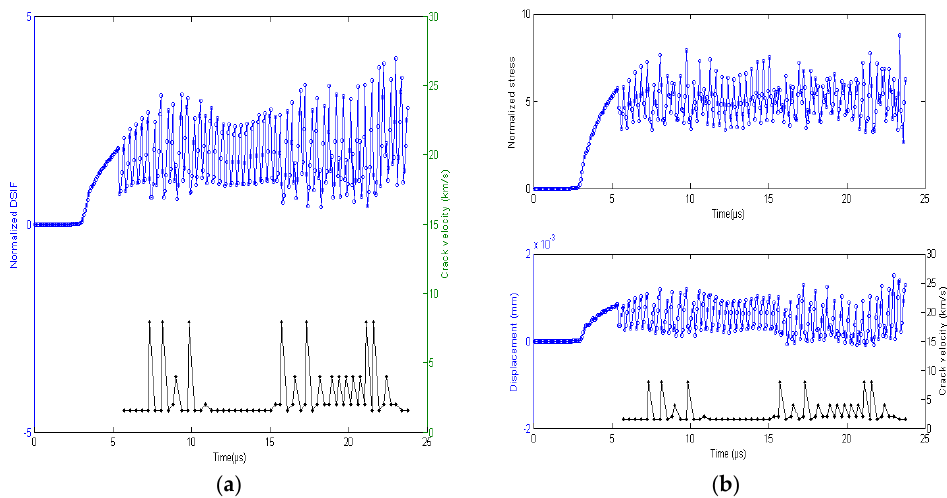
Figure 11. Dynamic stress intensity factor ( ) and crack propagation speed ( ) for σ c = 450MPa ( a ); and the stress and displacement near the crack tip for σ c = 450MPa ( b